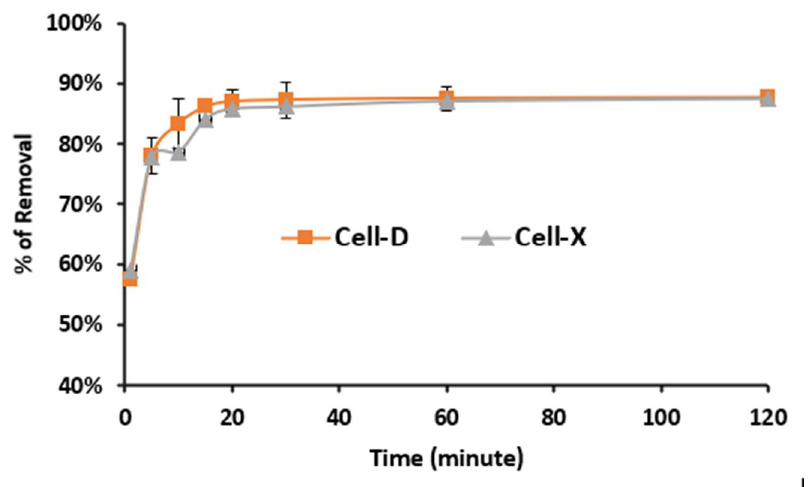
Figure 4. Effect of time on adsorption efficiency of Cell-X and Cell-D (C o : 10 ppm, dosage: 10 mg, temperature: 20 °C, volume: 10 mL, pH: 7).